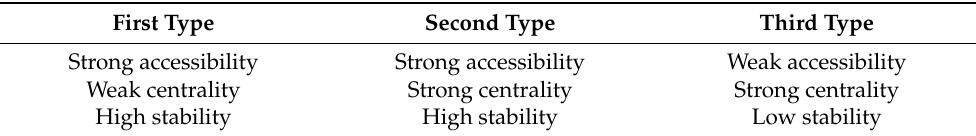
Table 4. Three types of collusive